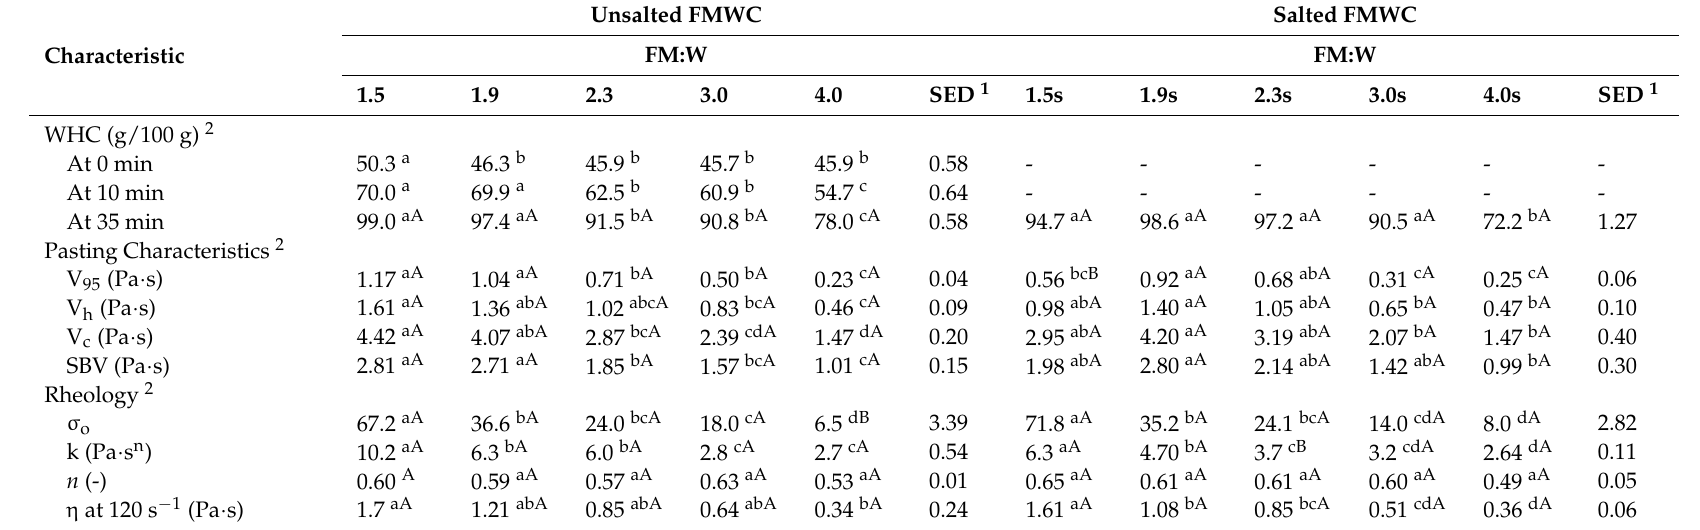
Table 3. Effect of ratio of fermented milk-to-parboiled wheat (FM:W) on the characteristics of reconstituted fermented milk–wheat composites (FMWC) 1,2 .